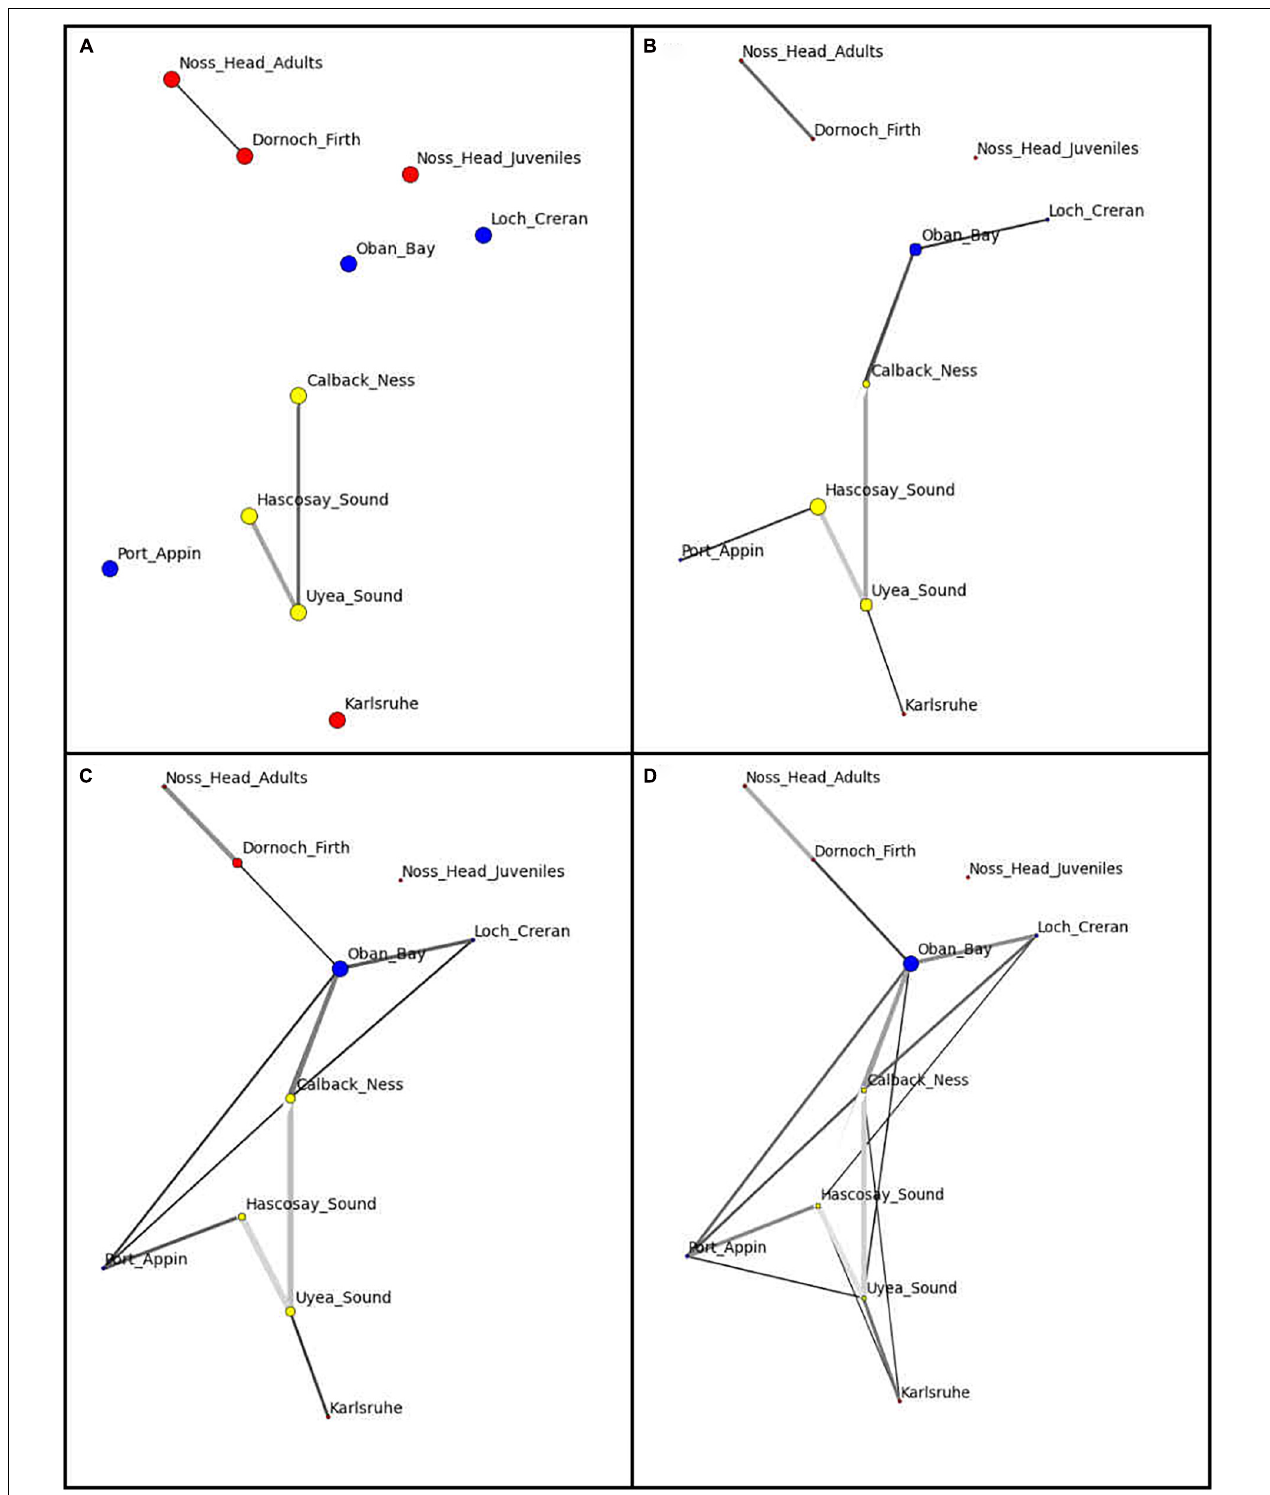
FIGURE 3 | Network visualization of Scottish M. modiolus populations at threshold values of (A) 0.03, (B) 0.04, (C) 0.05 (automatic threshold) and (D) 0.06. Network nodes indicate populations with node color indicating region (yellow: Shetland Isles, blue: West Coast; red: North-East and Orkney Islands) and node size indicating betweenness value. Nodes with a higher number of connecting edges have stronger connectivity to neighboring nodes. Strength of a genetic relationship between two nodes is visualized according to edge weight (darker = stronger).